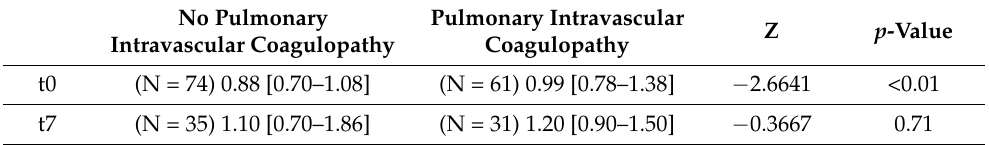
Table 5. Comparison of plasma CGRP levels (ng/mL) at baseline and after 7 days of hospitalization between patients with or without pulmonary intravascular coagulopathy. Values are expressed as median (IQR). Bold text highlights the statistically significant results. N = number of analyzed